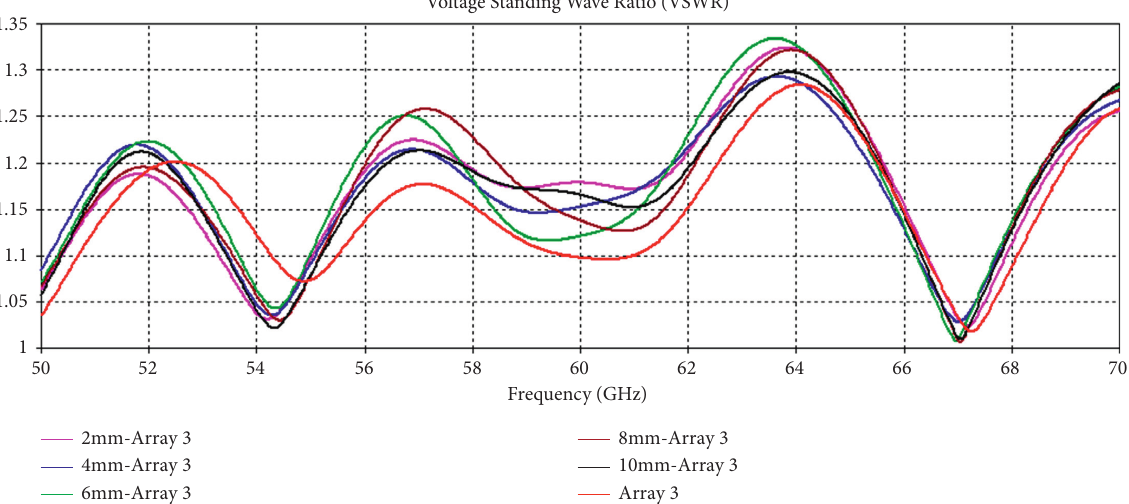
Figure 26: Array 3 on-body VSWR at different distances compared to free